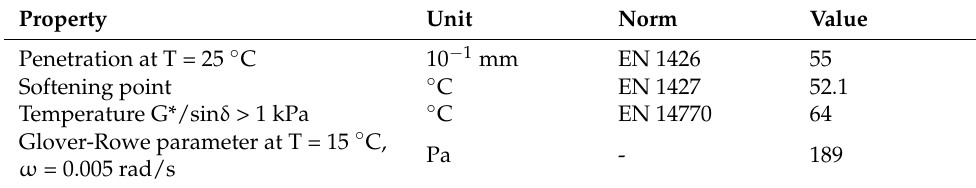
Table 4. Characteristic peaks of the rejuvenators from FTIR analysis. Table 3. Characteristics of the virgin bitumen. (The code “G*” indicates the norm of the co mplex modulus)